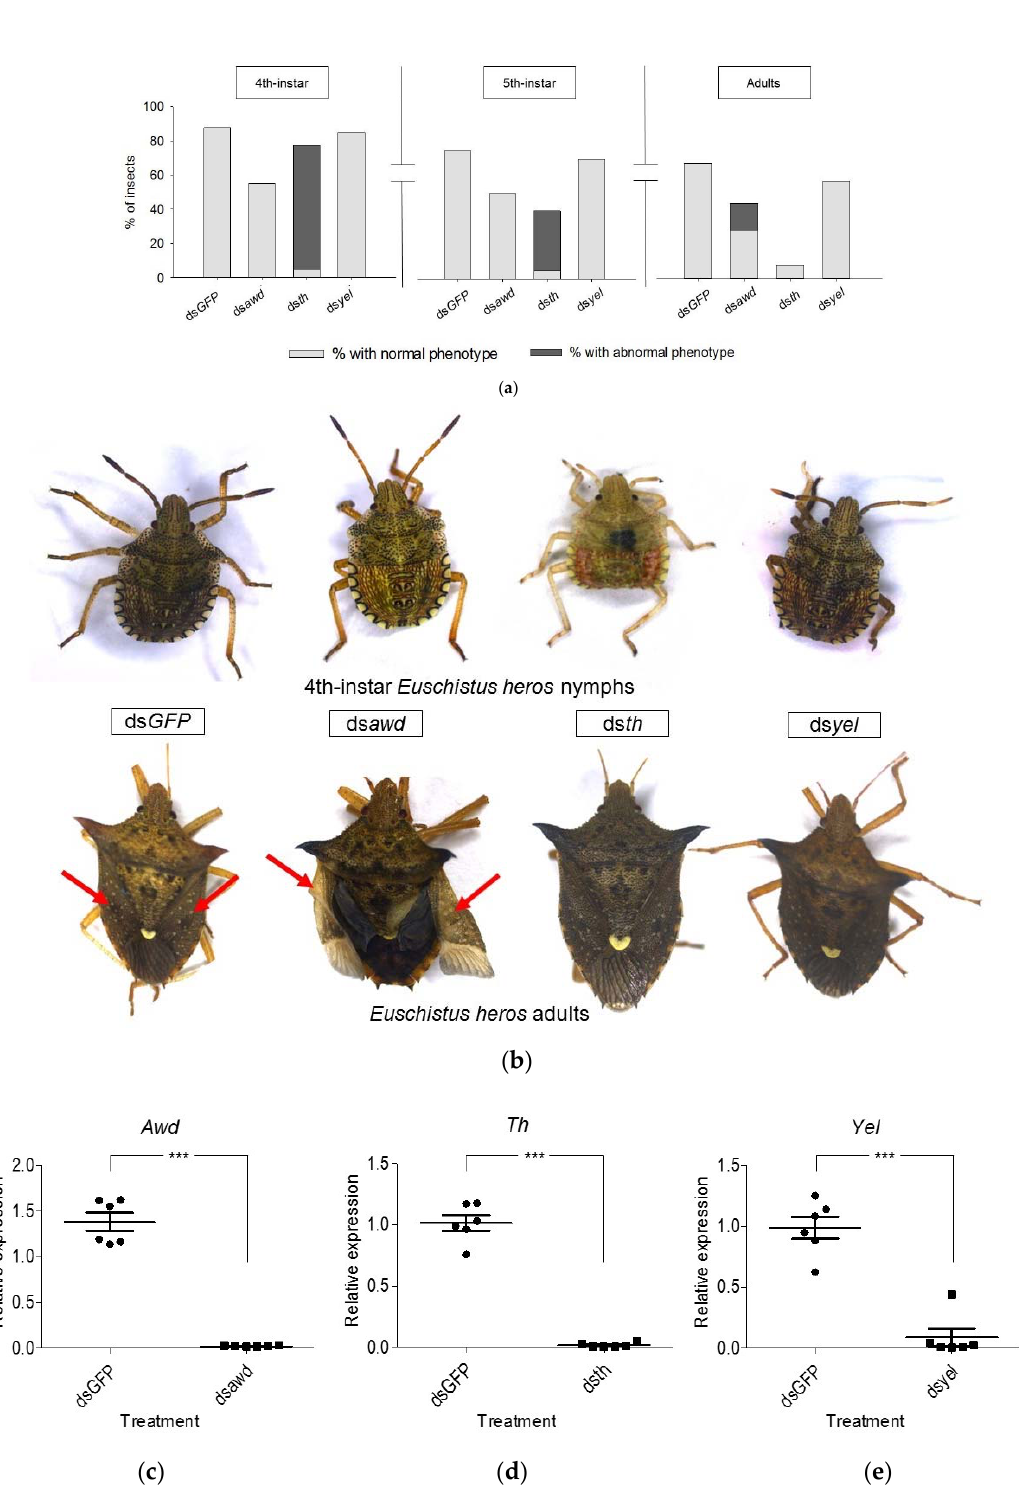
Figure 1. RNAi ‐ mediated knockdown of 3 genes, abnormal wing disc ( awd ), tyrosine hydroxylase ( th ) and yellow ( yel ) in E. heros. ( a ) Percentage (%) of insects with normal phenotype and abnormal phenotype (4th ‐ and 5th ‐ instar nymphs and adults) following microinjection with either ds awd , ds th or ds yel . Bars represent the mean. ( b ) Phenotypes in 4th ‐ instar nymphs and adults following the treatment of 3rd ‐ instar nymphs with either ds awd , ds th or ds yel . Red arrows indicate the location of the wings. The assay was conducted twice with each repeat consisting of 20 nymphs (N = 40). ( c – e ) Transcript levels at 72 h after injection of 3rd ‐ instar with ds awd , ds th and ds yel , respectively, compared to their respective transcript levels in the control (ds GFP ). Three asterisks on the bar indicate a statistically significant difference ( p < 0.001). Each sample contains 2 pooled insects. The p ‐ values were calculated by unpaired t ‐ test.